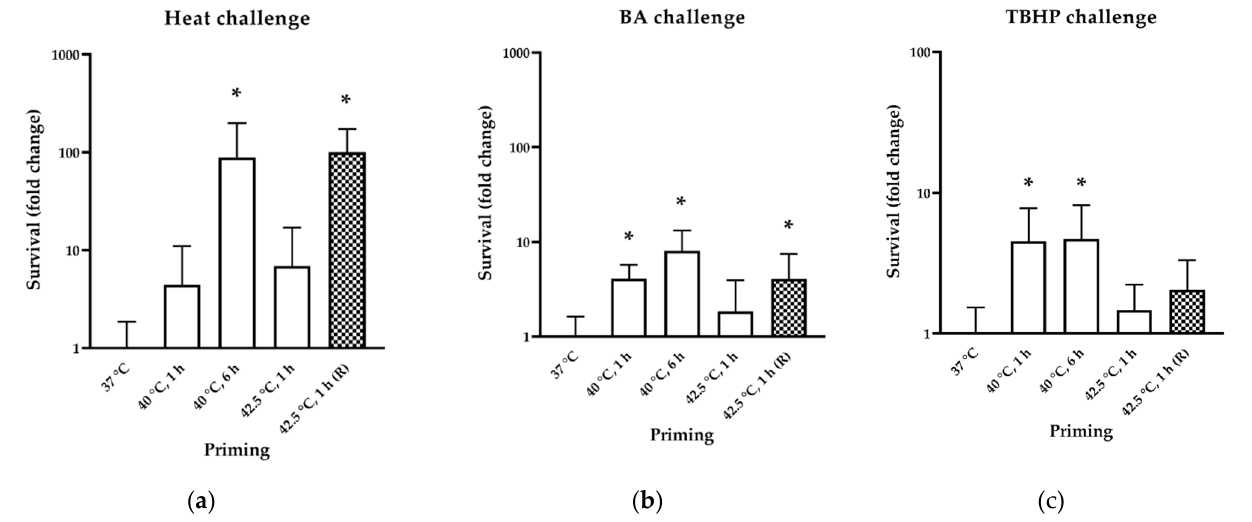
Figure 2. Acquired stress tolerance of heat-primed CHO cells. The quantitative analysis is based on colony formation assay. Primings were 1, 6 h at 40 °C or 42.5 °C for 1 h without or with 6 h recovery (R/checkerboard pattern) at 37 °C, which was followed by ( a ) a heat challenge with 46 °C for 20 min, ( b ) membrane fluidizing challenge by 95 mM BA for 20 min or ( c ) oxidative challenge by 250 µM TBHP for 3 h. Survival is represented as fold change compared to non-primed controls (37 °C). All data represent the means ± SD; n ≥ 3, p < 0.05 was considered statistically significant. Non-paired t - test was used for statistical comparisons, in which * denotes significant difference compared to 37 °C samples that received heat or BA challenge. See experimental setup and colony formation assay images in Supplementary Figure S4.